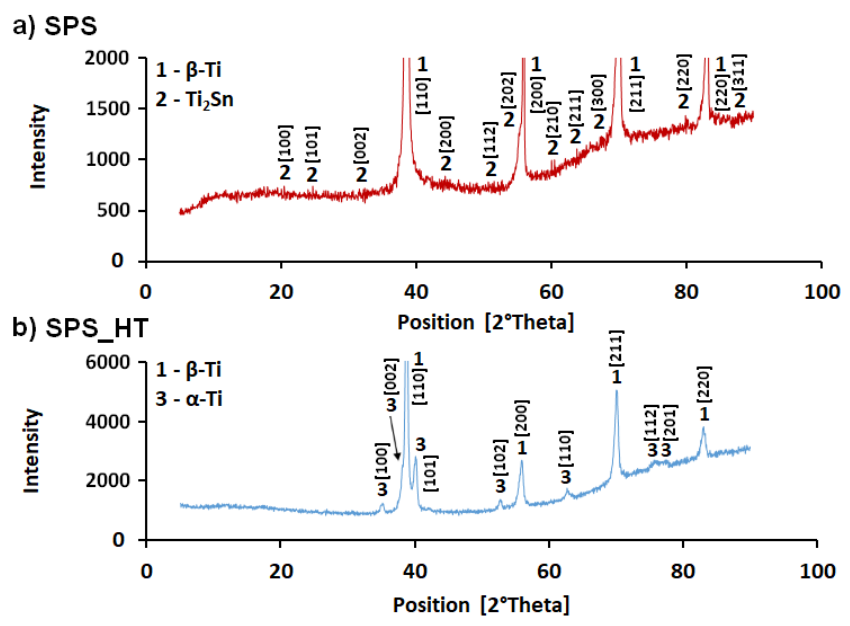
Figure 7. Diffraction patterns of Ti-25Nb-4Ta-8Sn alloy: SPS sample ( a ) and heat-treated sample ( b ). During annealing, the Sn-rich phase dissolved, and the β -Ti phase (BCC) partially